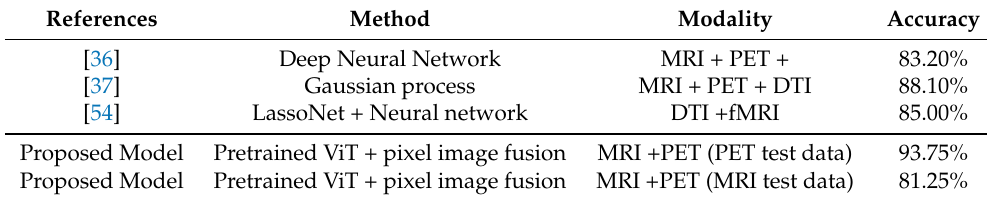
Table 4. The comparison results of EMCI vs AD classification with existing